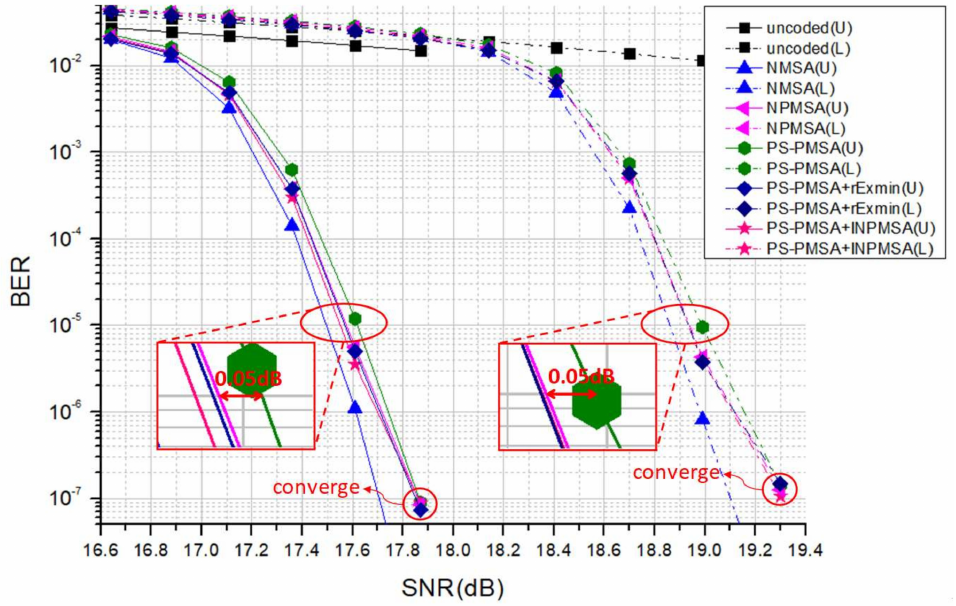
Figure 4. Simulation results of the improved PS-PMSA in the NAND flash channel